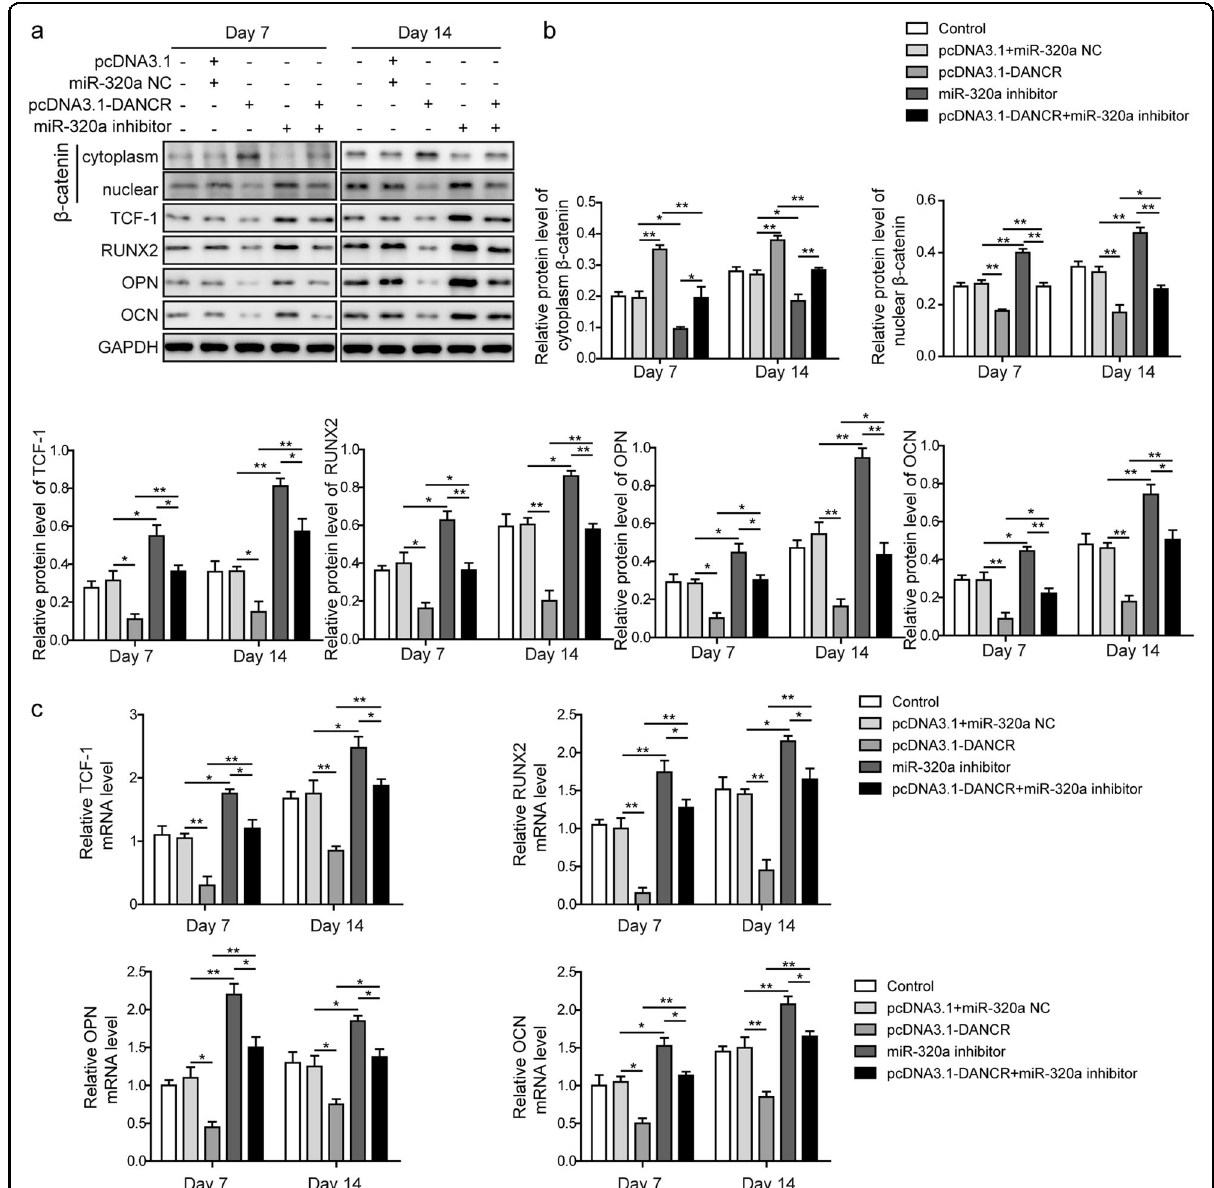
Fig. 7 DANCR overexpression suppressed the promoting effect of the miR-320a inhibitor on the β -catenin signaling pathway. BMSCs were infected with lentivirus encoding miR-320a inhibitor and/or DANCR overexpression vector and further incubated in osteogenic differentiation inducing medium for 7 or 14 days. a Cells were lysed, and western blot analysis was performed to analyze the protein expression of β -catenin in the cytoplasm and nucleus, TCF-1, RUNX2, OPN, and OCN. b Quantitative analysis of protein expression in a . c Relative mRNA levels of TCF-1, RUNX2, OPN, and OCN were evaluated by qRT-PCR. All experiments were conducted independently at least three times. * P < 0.05 and ** P <